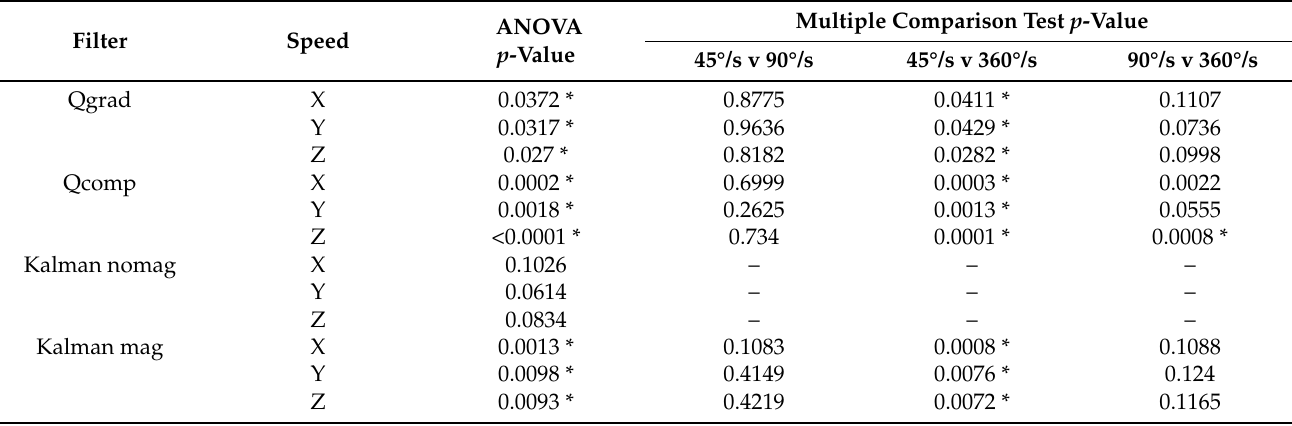
Figure 2. Rotation θ output of the individual IMUs fused with the Kalman filter for all angular velocities, stratified by axis of rotation. Derived from (1), θ = 2arccos ( q 1 ) Table 6. Results of ANOVA and multiple comparison tests for the difference in mean error during rotations executed at 45°/s, 90°/s, and 360°/s. Significant differences ( p < 0.05) indicated with an asterisk